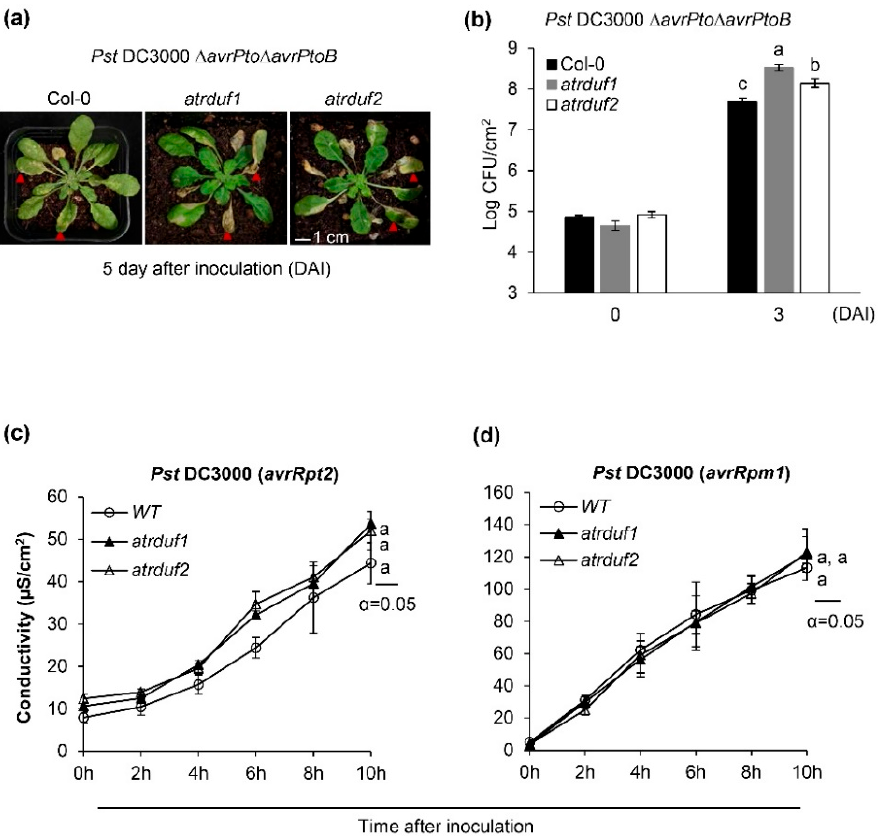
Figure 4. Functions of AtRDUF1 and AtRDUF2 during plant immune signaling. ( a ) Disease symp- toms of wild-type (WT) Col-0 and atrduf mutants at 5 days after spray-inoculation with Pst DC3000 ∆ avrPto ∆ avrPtoB (OD 600 = 0.8). ( b ) Bacterial growth in Col-0 wild-type (WT) and atrduf mutants. Bacterial growth was determined at 0 and 3 days after inoculation (DAI). Error bars represent the standard deviation of five replications. Similar results were obtained in at least three independent experiments. Different letters indicate significant differences between plant genotypes at 3 days after inoculation ( α = 0.05, one-way ANOVA and Tukey’s HSD test; JMP software). ( c , d ) Ion leakage assays of 5-week-old wild type (WT), atrduf1 , and atrduf2 mutant plants inoculated with avirulent strains of Pst DC3000 expressing avrRpt2 (OD 600 = 0.1) ( c ) or avrRpm1 (OD 600 = 0.1) ( d ). Error bars represent the standard deviation of three replicates. Similar results were obtained in at least two independent experiments. Different letters indicate significant differences between plant genotypes at 10 h post inoculation ( α = 0.05, one-way ANOVA and Tukey’s HSD test; JMP 15 software).